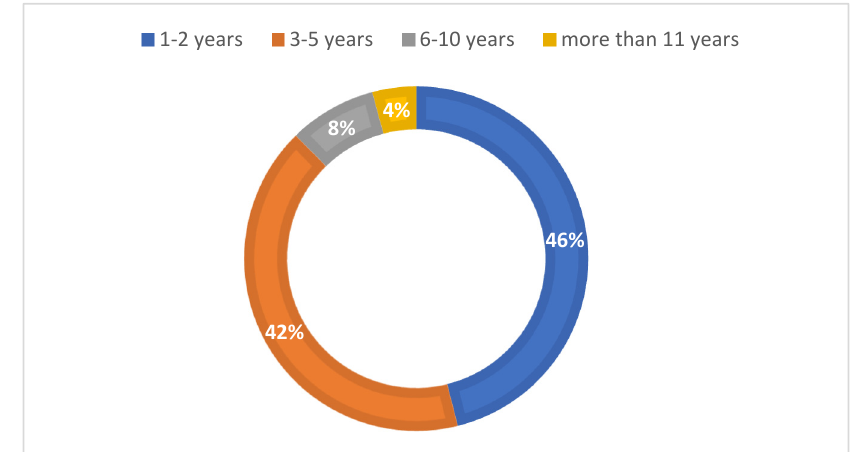
Figure 4. Usage of BIM technology in high-rise buildings.